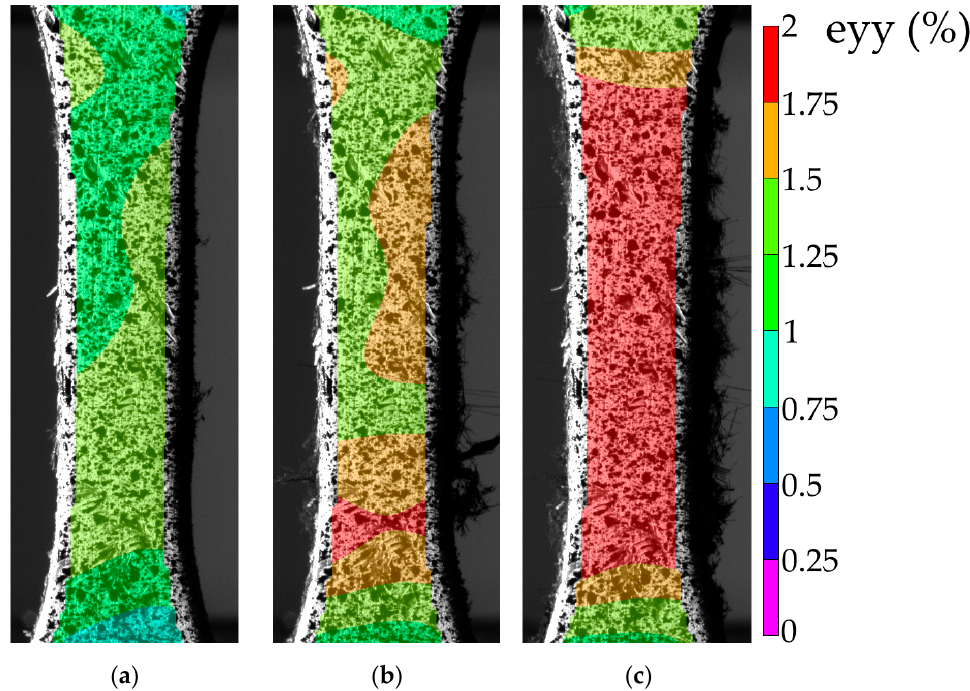
Figure 10. The strain development in the HCF tests: 1000 ( a ); 3000 ( b ); 7000 cycles ( c ).